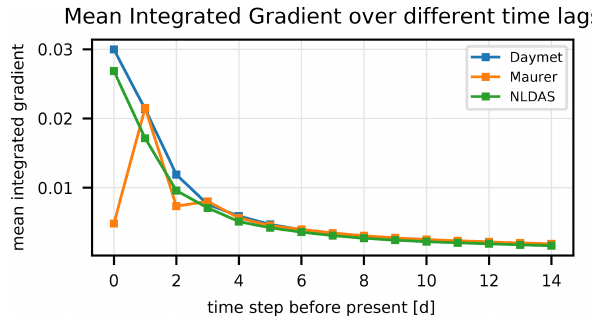
Figure 6. Time- and basin-averaged integrated gradients of one of the n = 10 multi-forcing LSTMs as a function of lag time (days be- fore current streamflow prediction) of the three precipitation prod- ucts. Because of the time shift shown in Fig. 2, the model learned to ignore the Maurer input at the current time